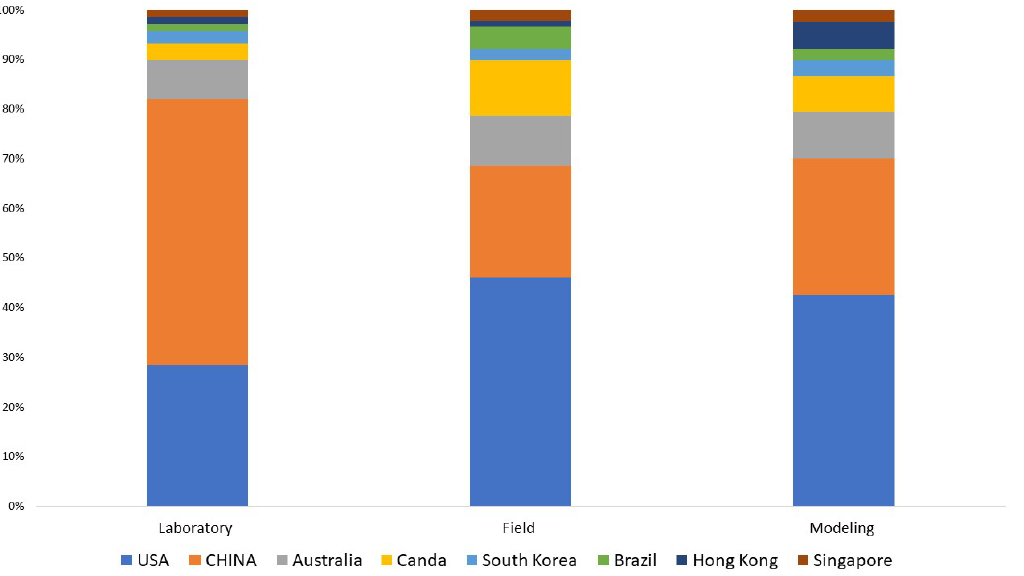
Figure 6. Leading countries in laboratory, field, and modeling studies on urban stormwater manage- ment by BRC, published